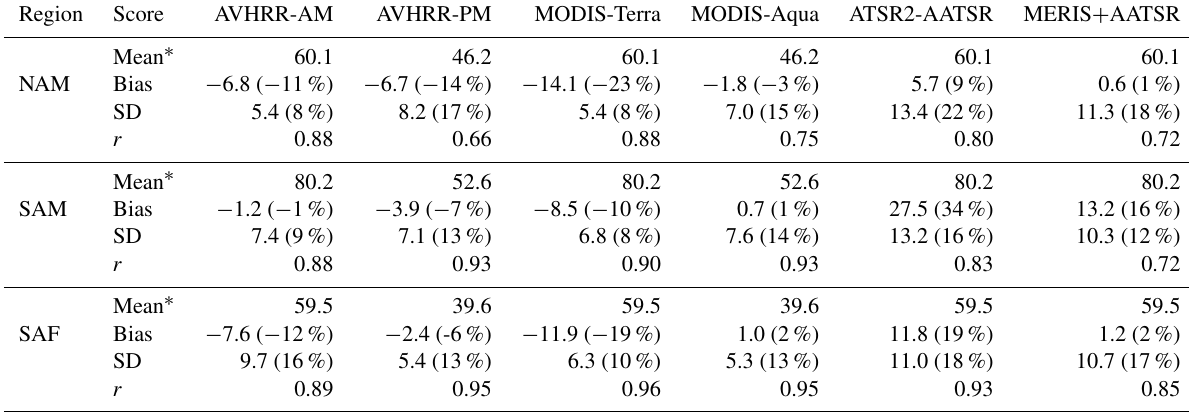
∗ The mean values given are for the reference data at 10:30 when compared against AVHRR-AM, MODIS-Terra, ATSR2-AATSR and MERIS + AATSR, and at 13:30 when compared against AVHRR-PM and